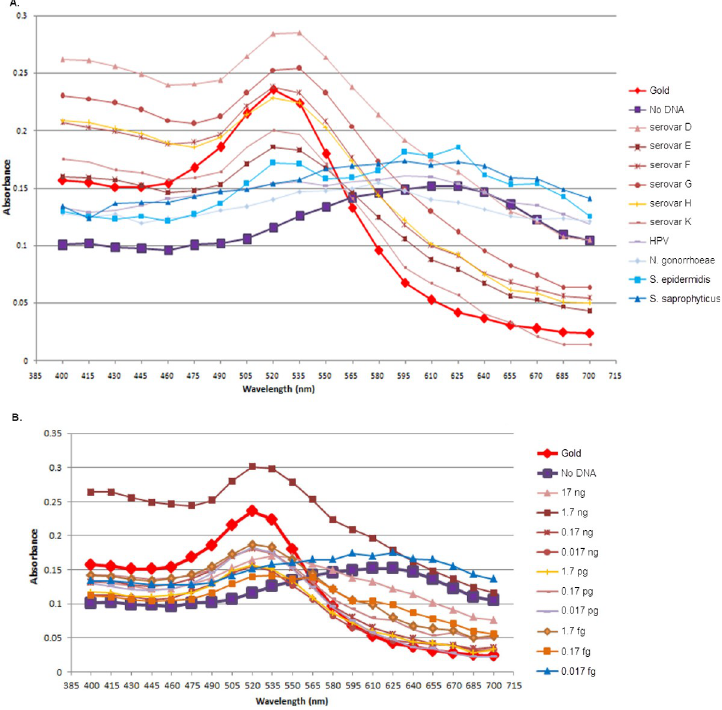
Fig 2. LAMP-AuNP followed by UV-vis spectrophotometry of the corresponding specificity (A) and sensitivity (B) assays in Fig 1B and 1D, respectively. The x-axis represents wavelength (nm). A shift of peak to a higher wavelength was observed for the no-template and negative test results. AuNP, gold nanoparticle probe; HPV, human papillomavirus; LAMP, loop-mediated isothermal